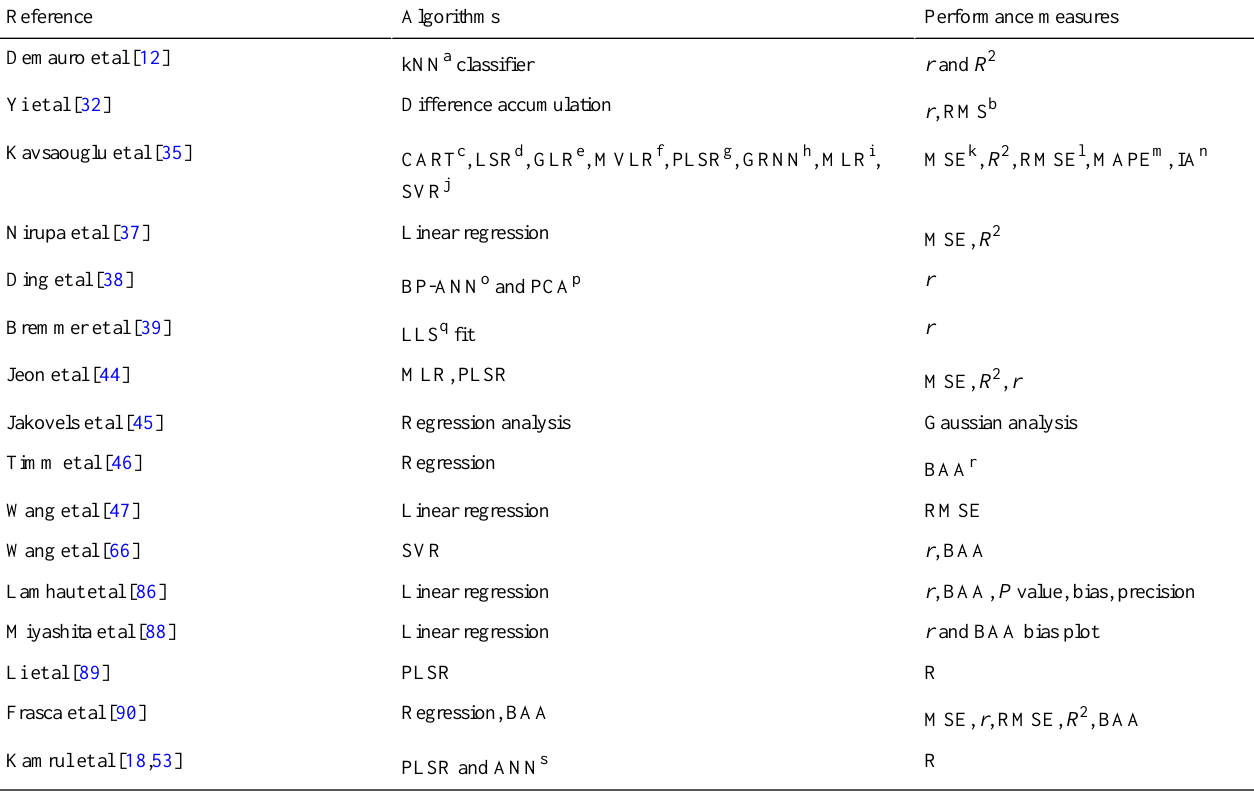
Table 3. Summary of machine-learning algorithms for noninvasive hemoglobin